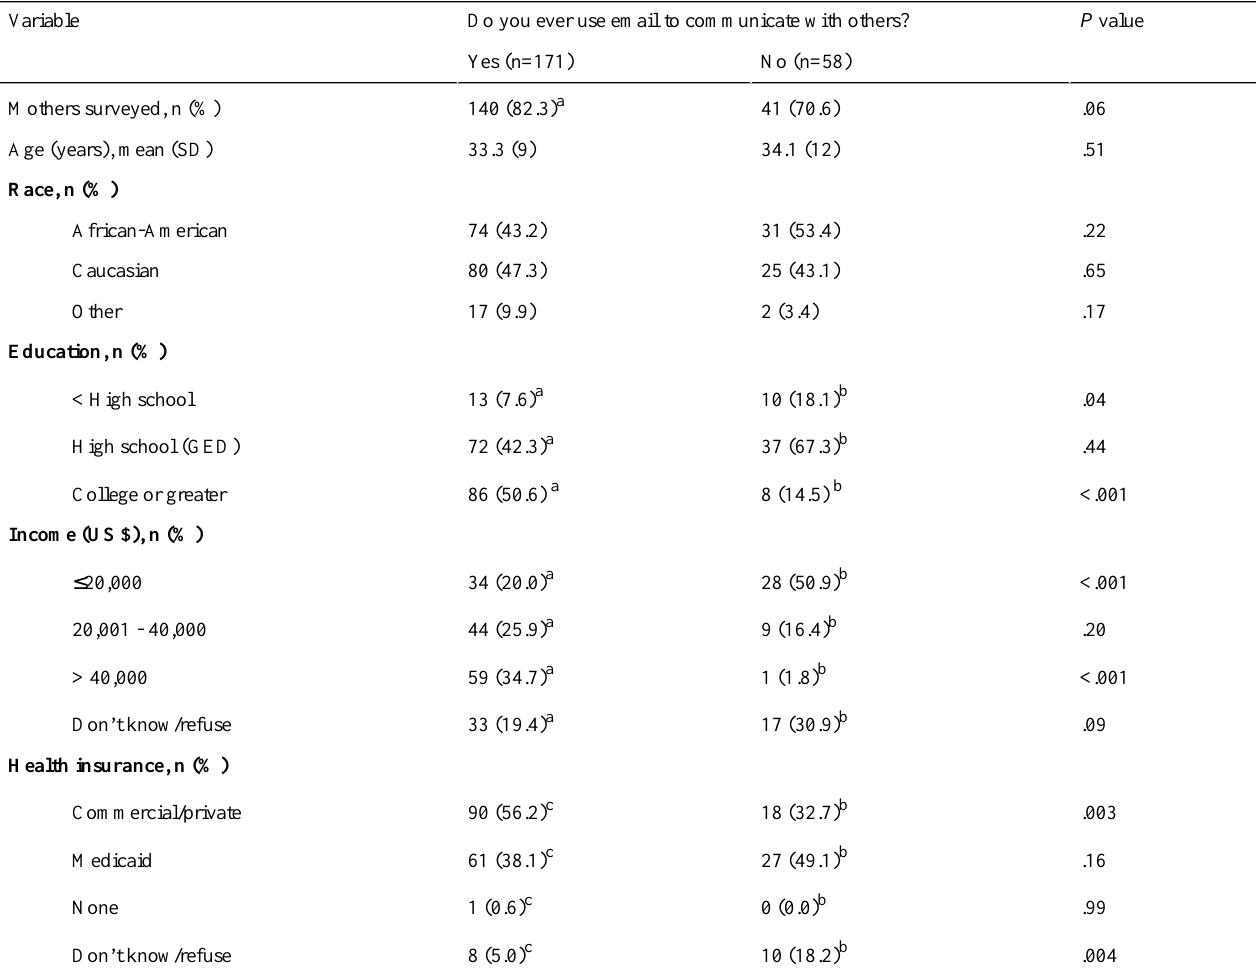
Table 1. Caregiver demographics by email usage (N=229).